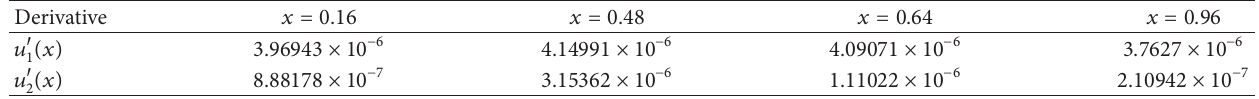
Table 3: Absolute error of approximating 𝑢 󸀠 1 (𝑥) and 𝑢 󸀠 2 (𝑥) for Example 1.